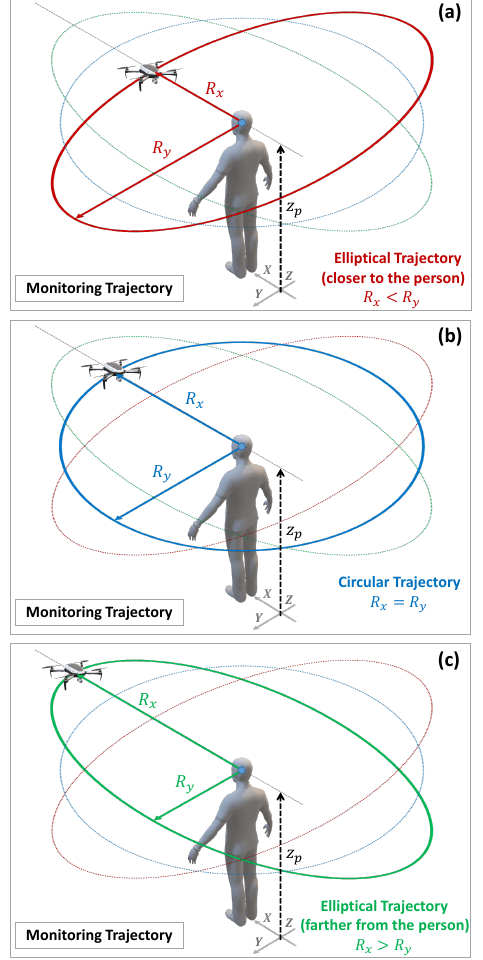
Figure 2. 3D representation in isometric perspective of the trajectory according to the UAV’s moni- toring radius: ( a ) elliptical trajectory closer to the person’s face ( R x > R y ); ( b ) circular trajectory in which the monitoring radius is constant ( R x = R y ); ( c ) elliptical trajectory farther from the person’s face ( R x < R y